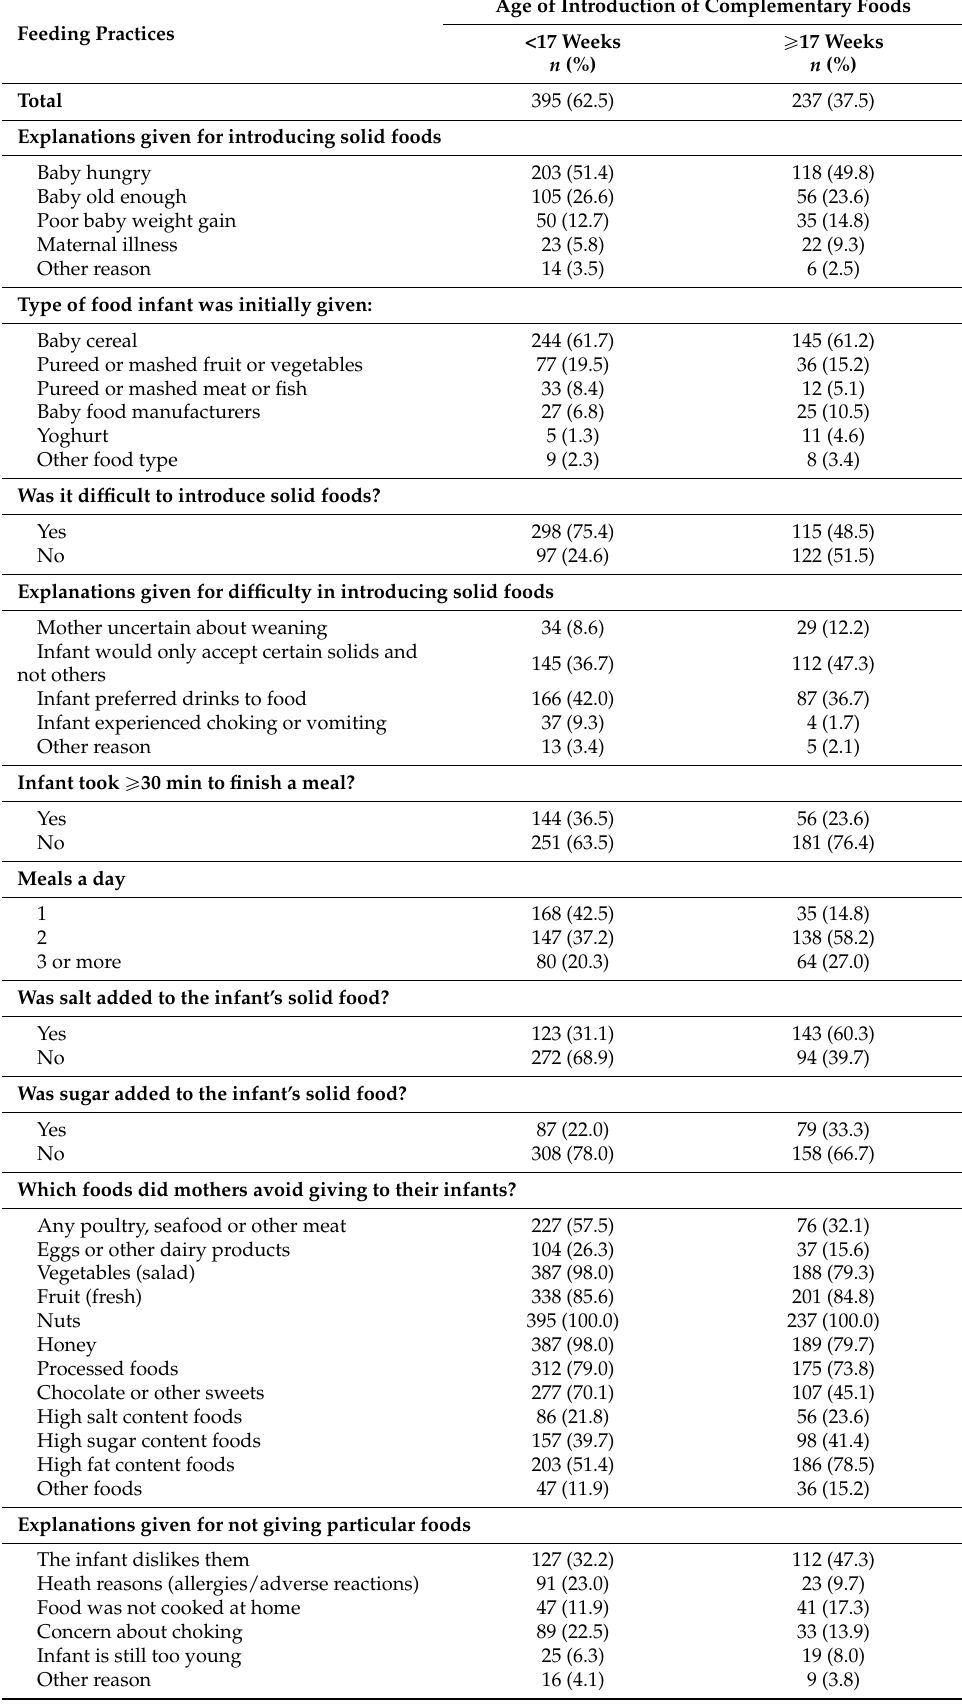
Table 2. Complementary feeding data by age of introduction ( n =